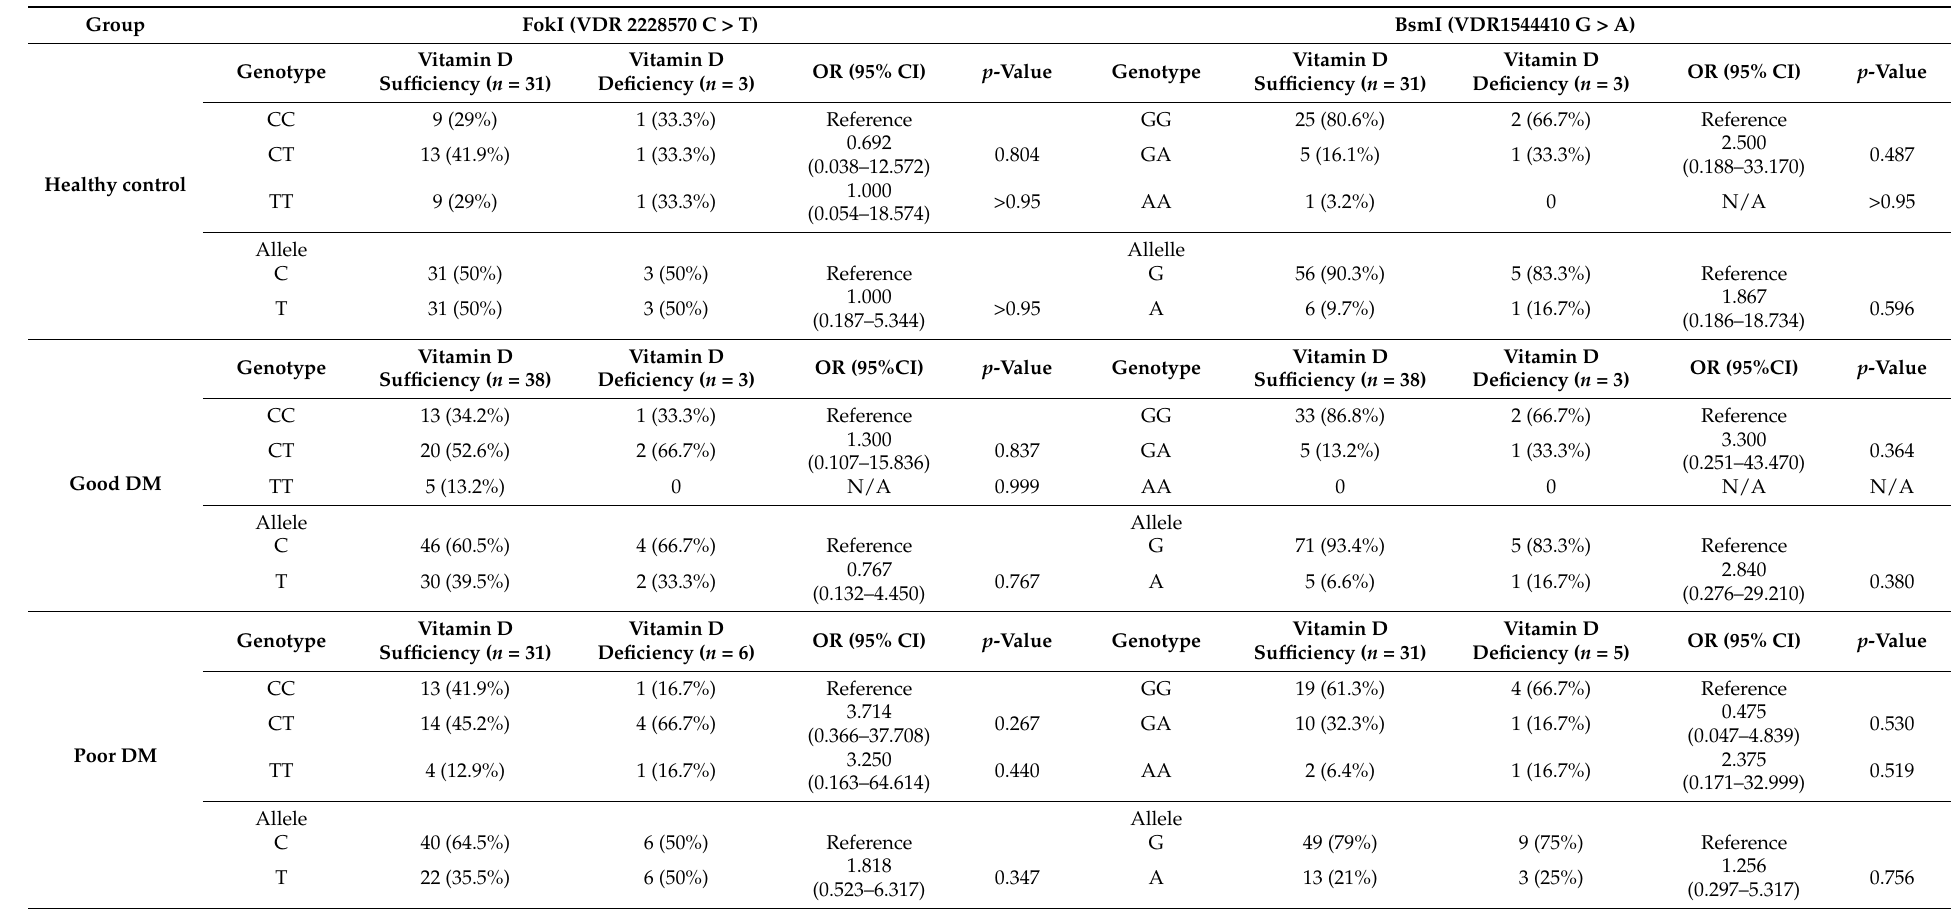
Table 5. Association between VDR polymorphism at FokI (VDR 2228570 C > T) and BsmI (VDR1544410 G > A) and risk of vitamin D